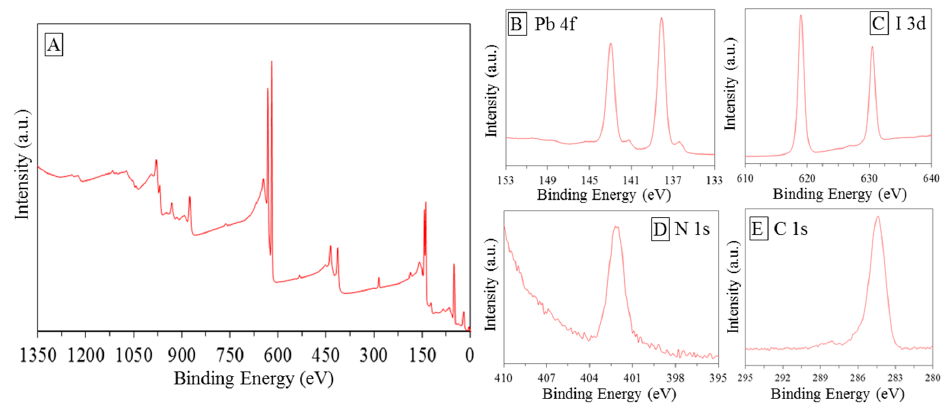
Figure 4. X-ray photoelectron spectroscopy (XPS) spectra of the as-prepared MAIPb: ( A ) general spectrum, ( B – E ) zooming on specific binding energy range